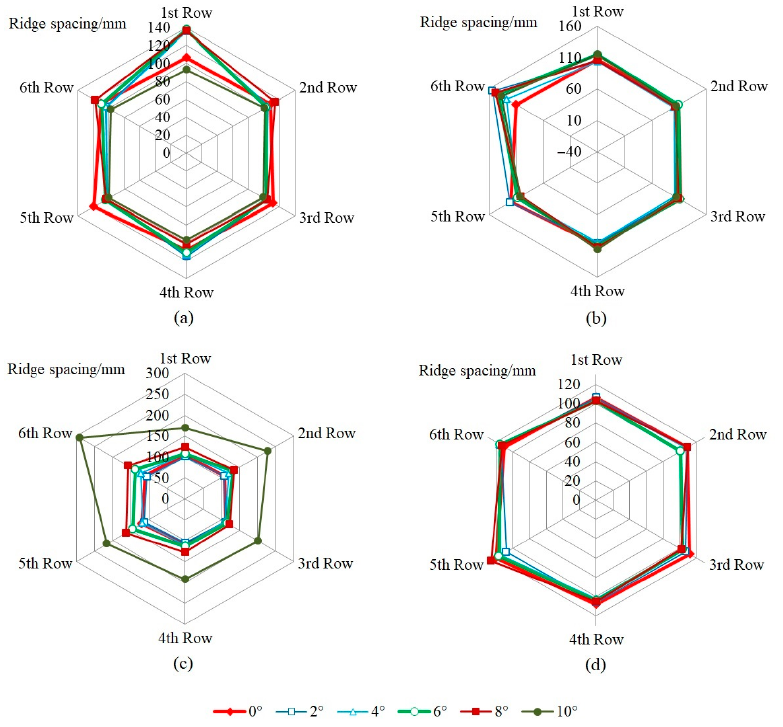
Figure 10. Effects of inclination angle on ridge spacing: ( a ) tilting to − X direction, ( b ) tilting to X direction, ( c ) tilting to − Y direction, and ( d ) tilting to Y direction.